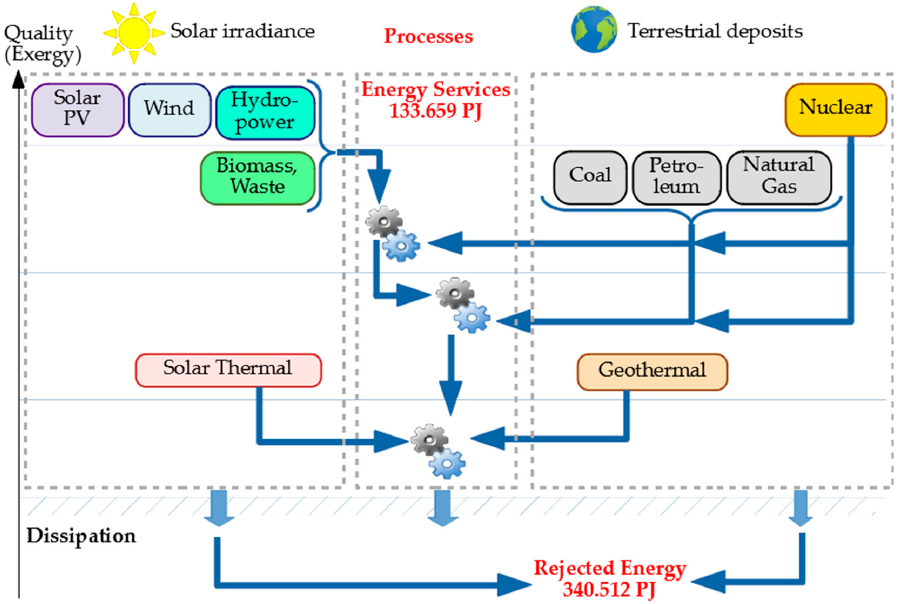
Figure 4. Energy cascading; data extracted from [70]. PV: photovoltaics.